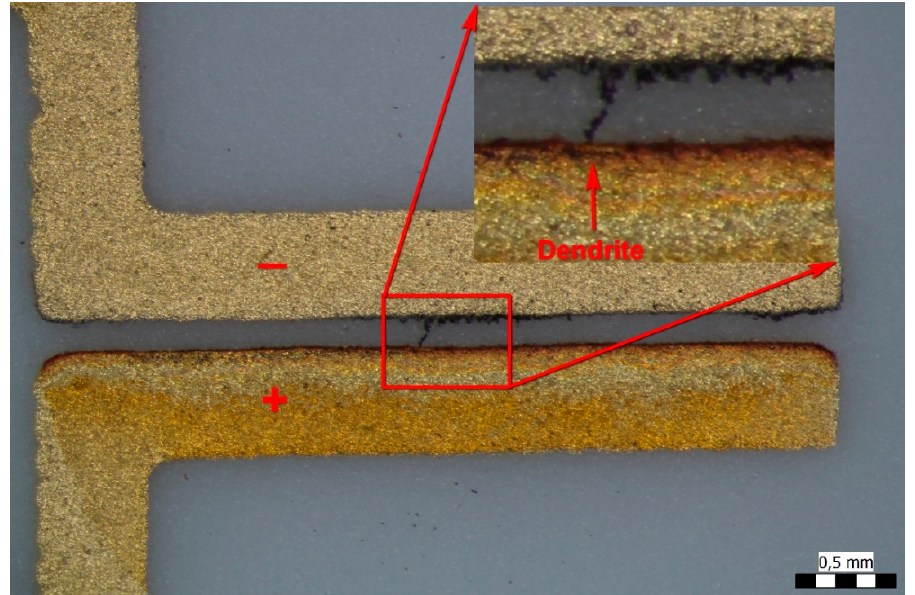
Figure 4. Gold dendrites after a WD test with an applied 10 V bias potential.